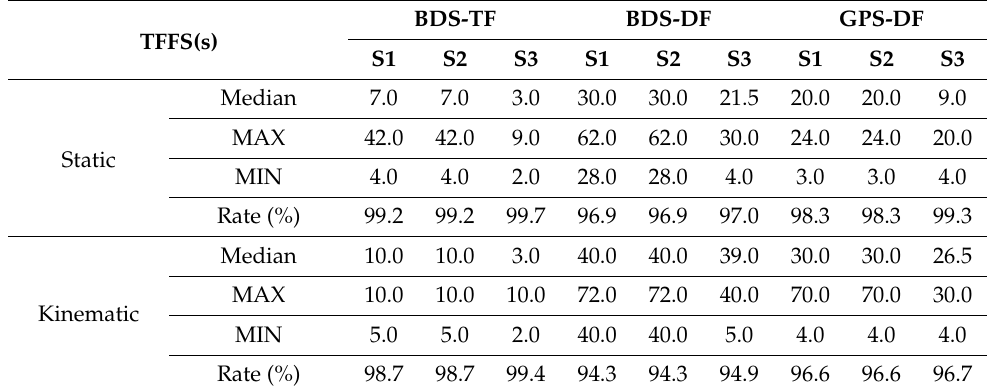
Table 3. Statistics of ambiguity fixing performance of Baseline B, Sampling rate 1 s.